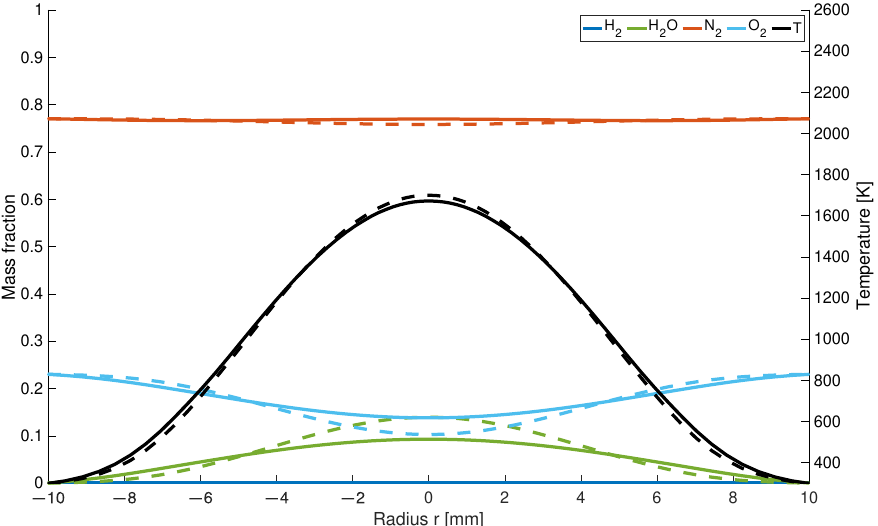
Figure 3. Temperatur and mass fraction at a height of 25 mm; solid line: with differential diffusion, dashed line without differential